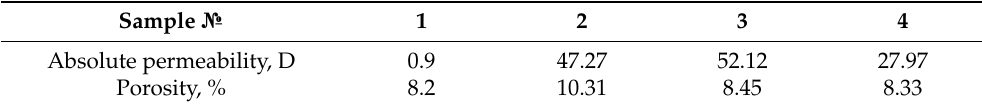
Table 2. Properties of core